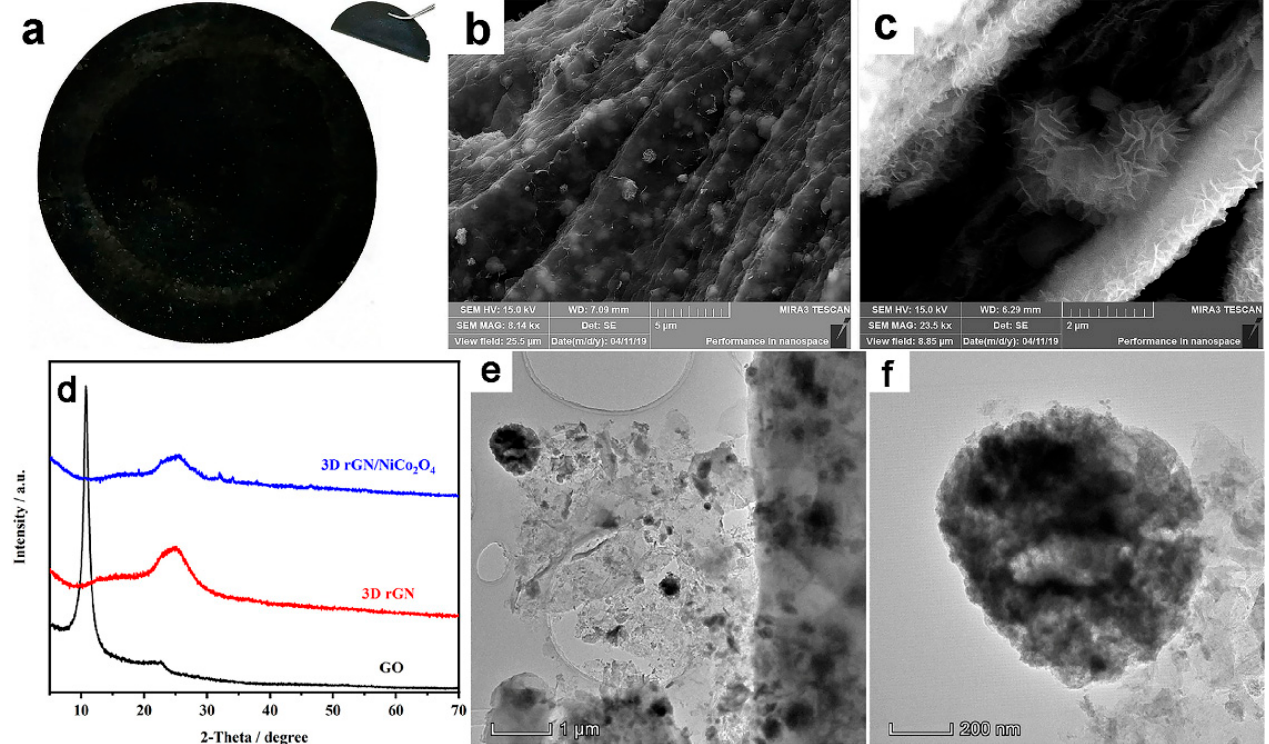
Figure 3. ( a ) Digital image ( b , c ) surface and cross-section SEM images of 3D rGO/NiCo 2 O 4 film, ( d ) XRD patterns, and ( e , f ) TEM images of 3D rGO/NiCo 2 O 4 . Reproduced with permission from